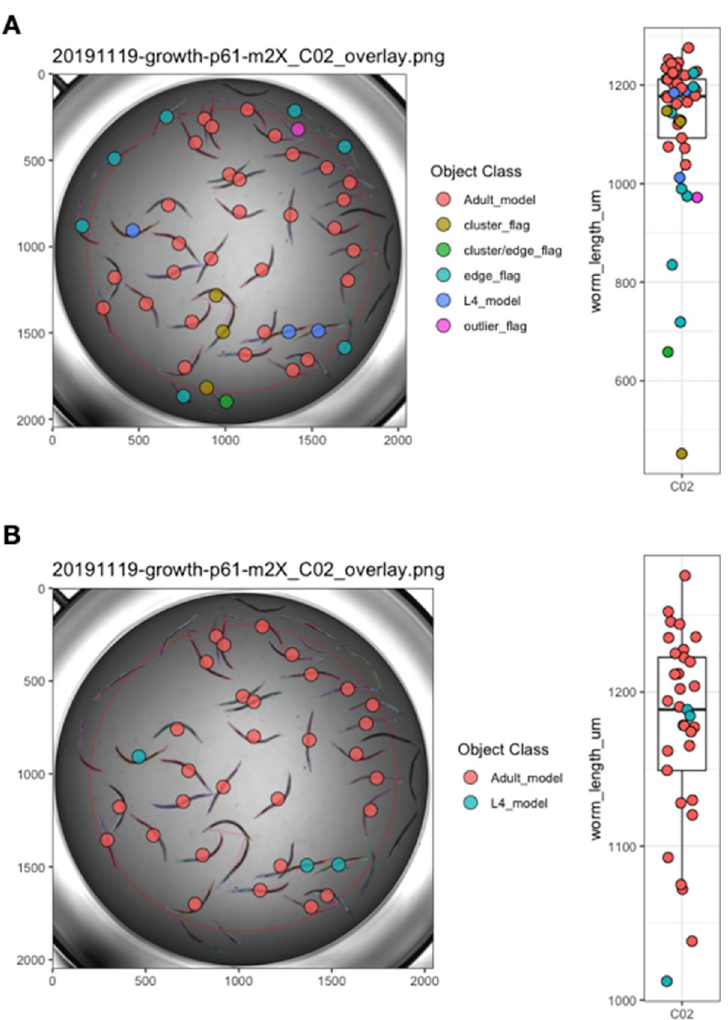
Fig 3. Example plots generated by viewWell() . The function viewWell() facilitates the exploration of data within an individual well. Well images displaying easyXpress raw (A) and processed (B) data are annotated with the location of each model object centroid (circles) and are colored by object class in the legend (left). Animals are outlined in different colors to indicate the model object(s) identified for each primary object (see S1 Fig). The length of each object is displayed as a boxplot (right). Well edge circumference defined by the function edgeFlag() is shown in red.